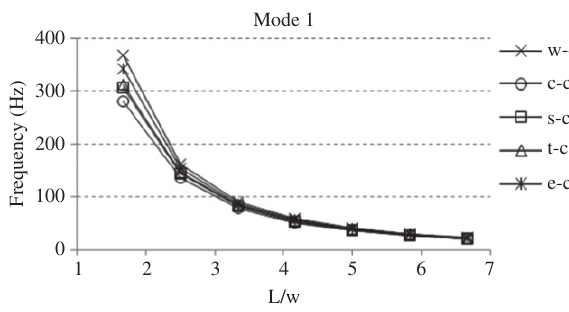
Figure 10 Effects of length of plate on natural frequencies.